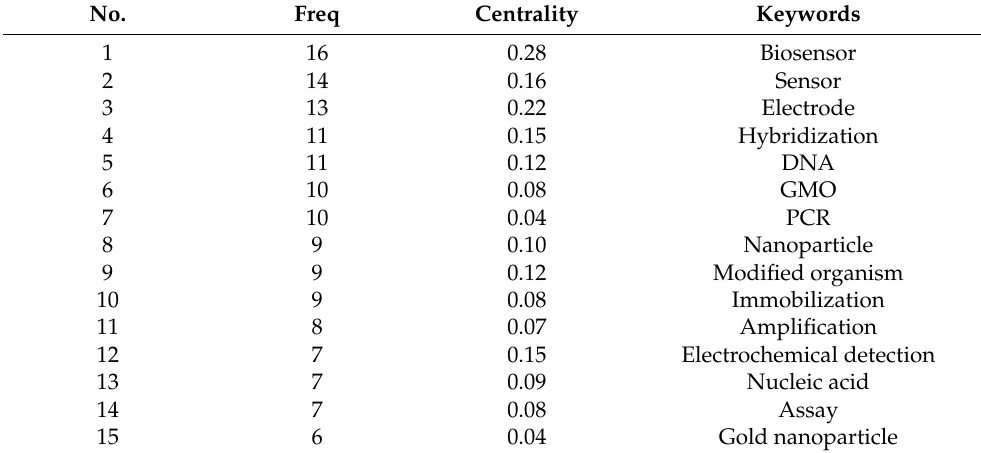
Table 3. List of top 15 keywords for electrochemical techniques for the detection and analysis of GM crops. No. Freq